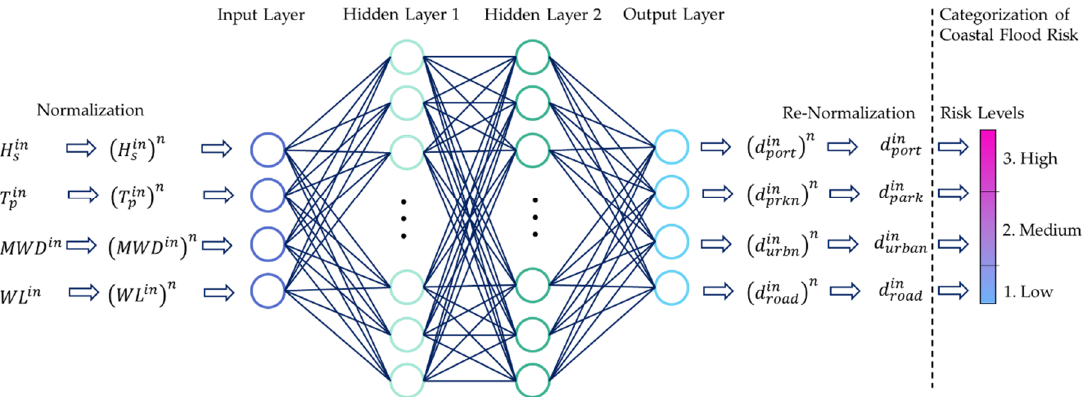
Figure 10. ANN architectures tested to predict the coastal flood risk.